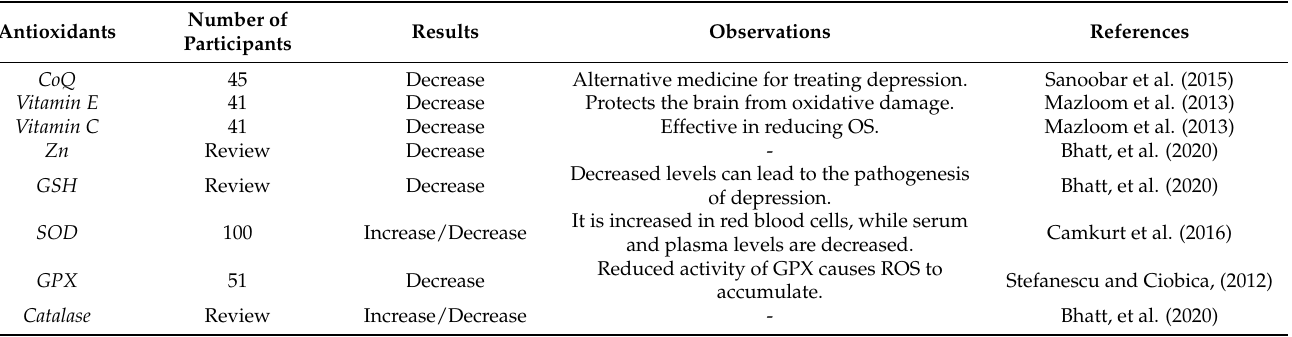
Table 3. Summary of antioxidant levels in